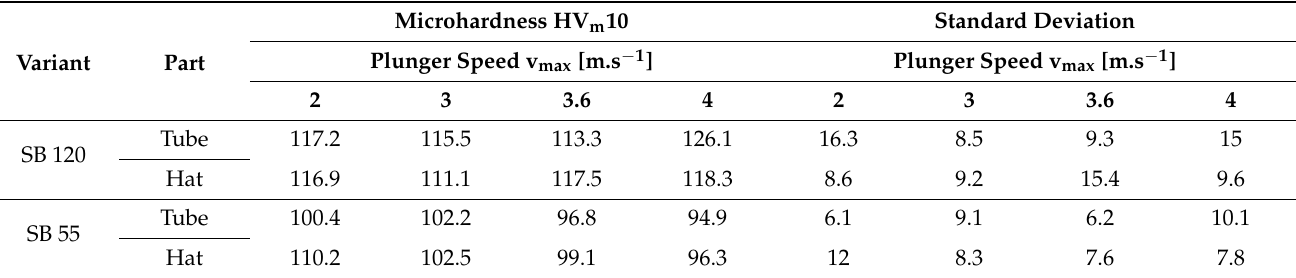
Table 6. Microhardness dependence on plunger speed v max